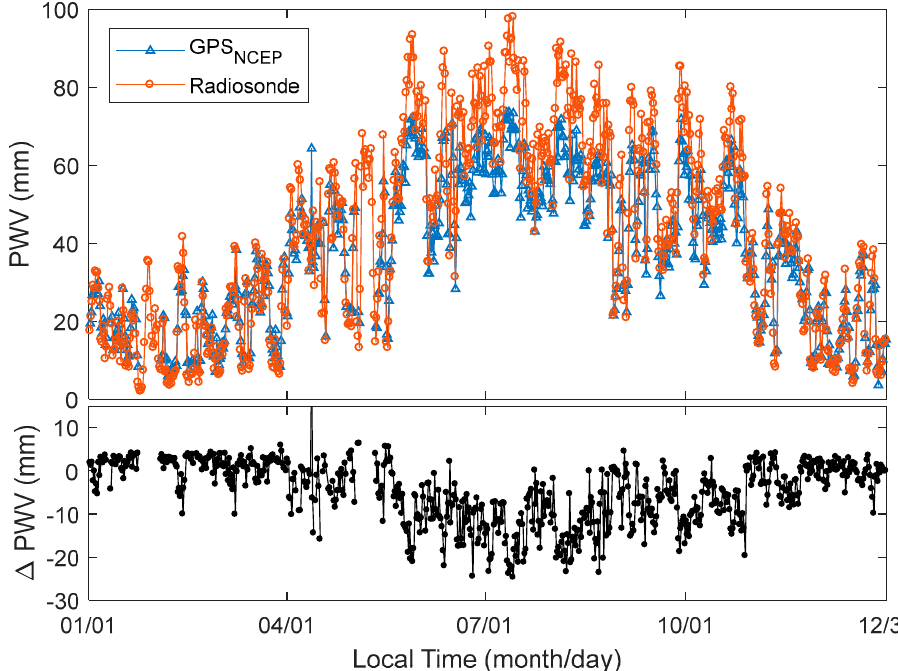
Figure A5. The PWV time series from GPS and radiosonde at GPS Quzh station and QUZO radiosonde station, respectively.